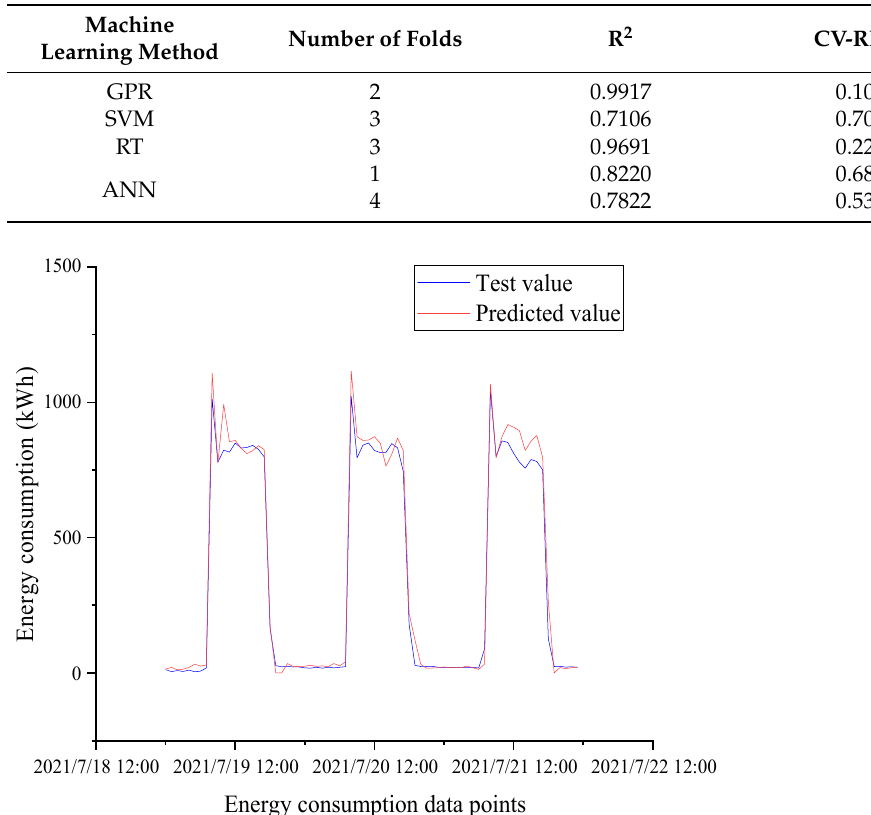
Figure 13. Fitting of building air-conditioning energy consumption in the period 19–21 July .